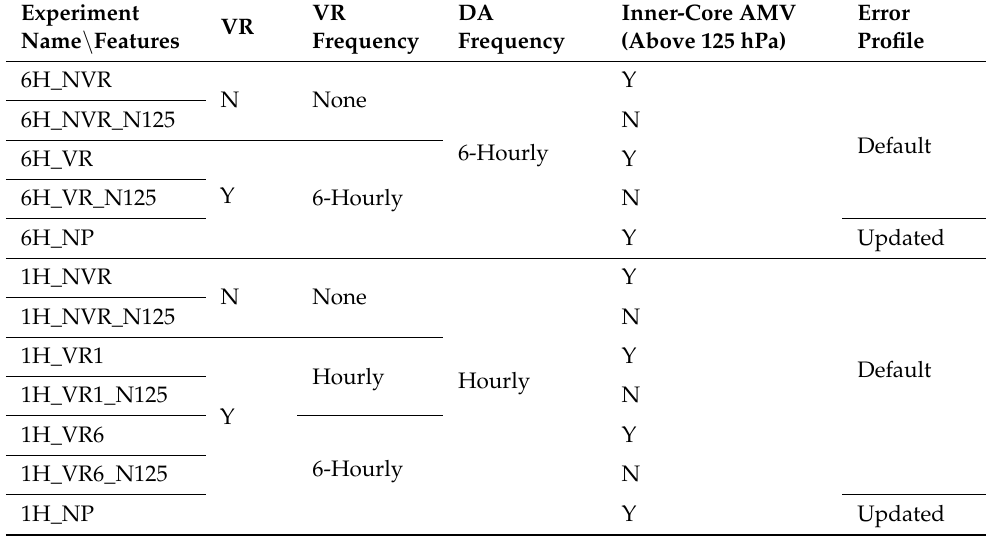
Table 2. List of